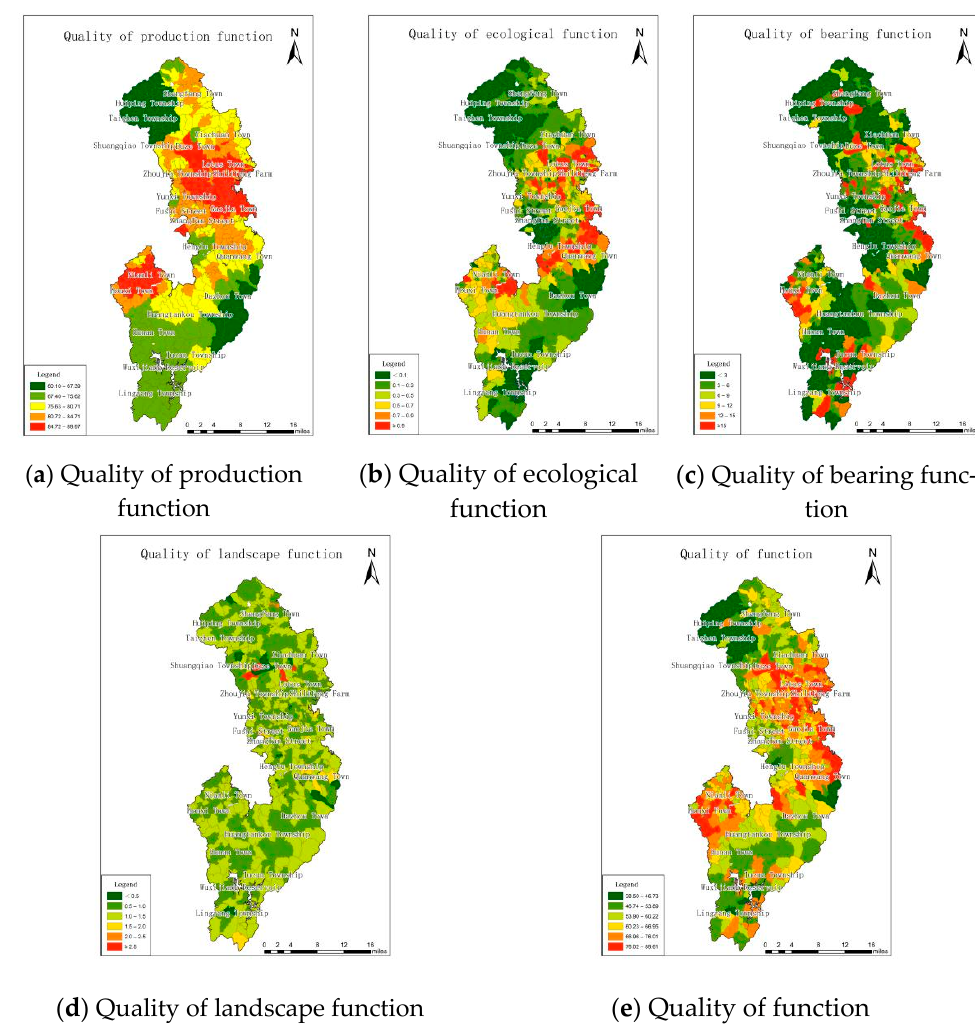
Figure 4. Evaluation of cultivated land production function, ecological function, landscape function, carrying function and functional quality.